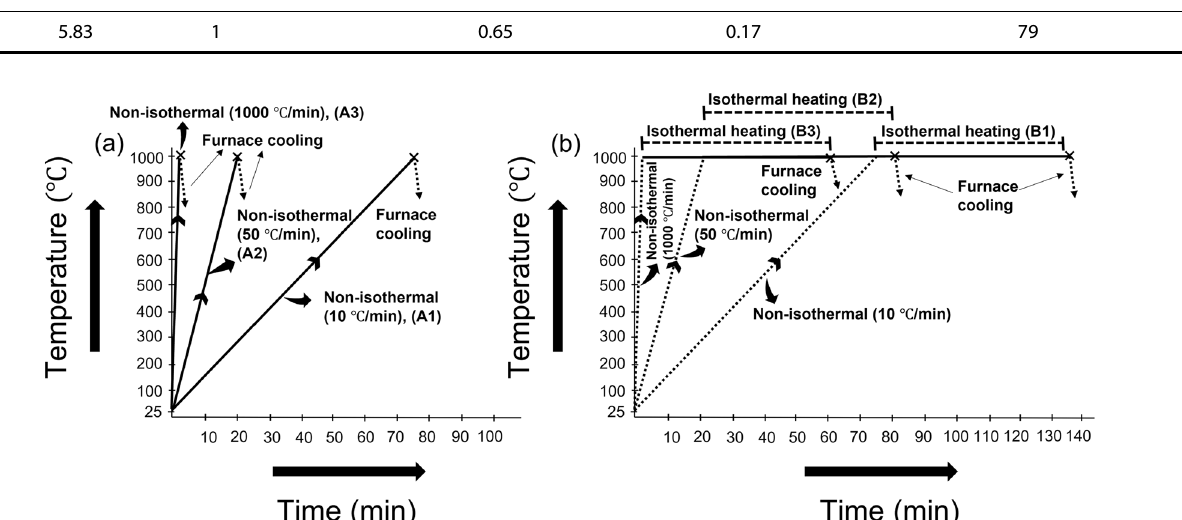
Table 2. Laser processing parameters used during L-DED fabrication of IN718. Power (W)